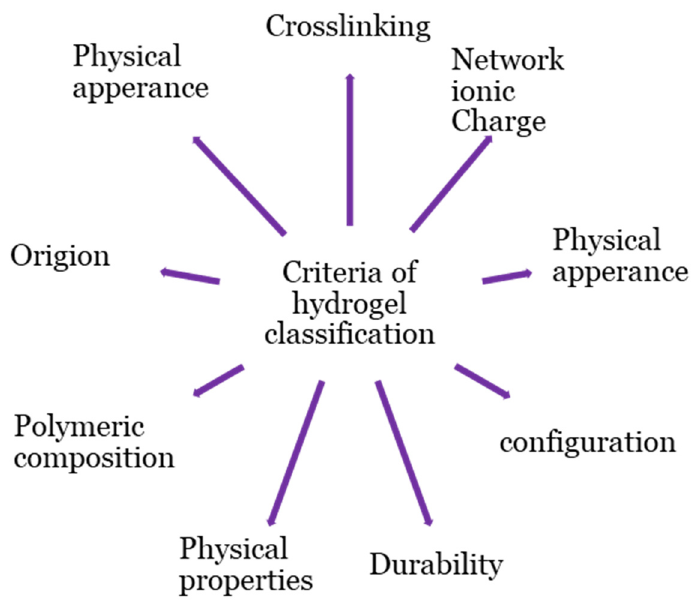
Figure 2. Classification bases of hydrogel.